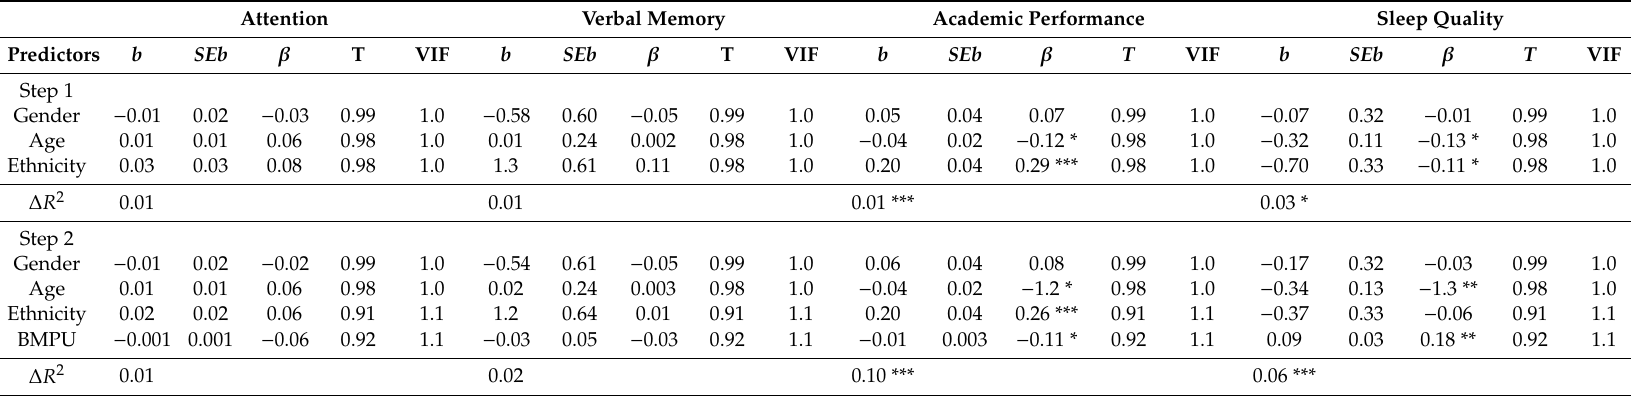
Table 3. Hierarchical multiple regression predicting cognitive functioning (attention and verbal memory), academic performance, and sleep quality ( n = 385). Attention Verbal Memory Academic Performance Sleep